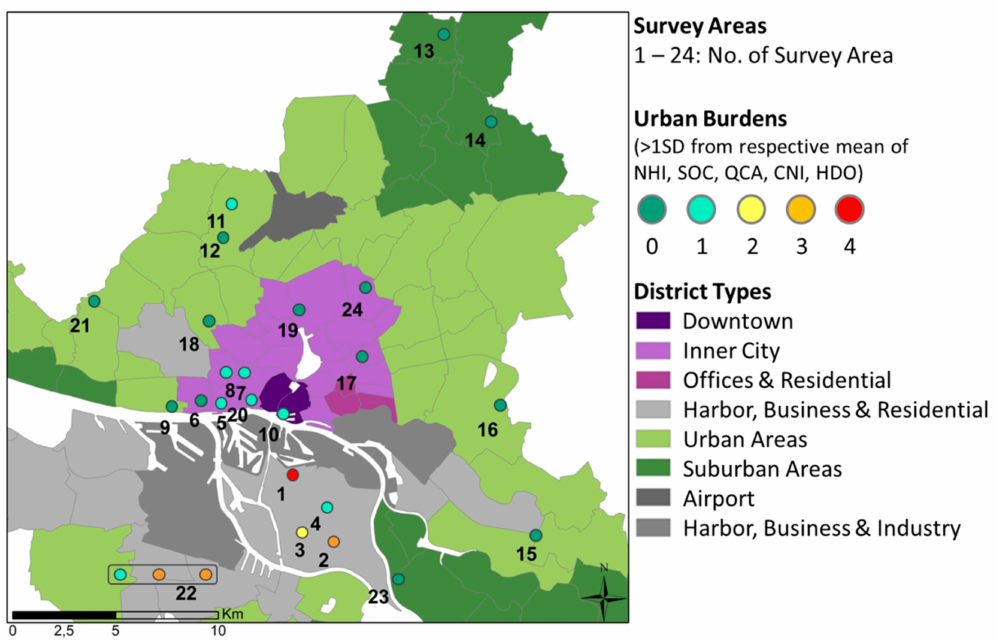
Figure 5. Location of study areas and burden by the identified urban variables ( > 1 SD from